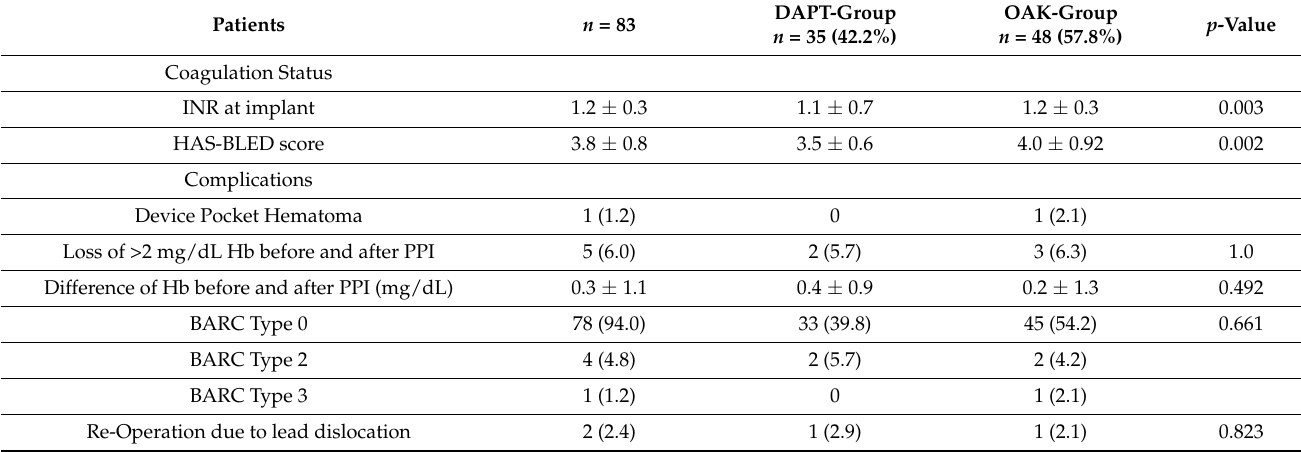
Table 5. Complications and coagulation status in the DAPT-group compared to the OAK-group. Patients n = 83